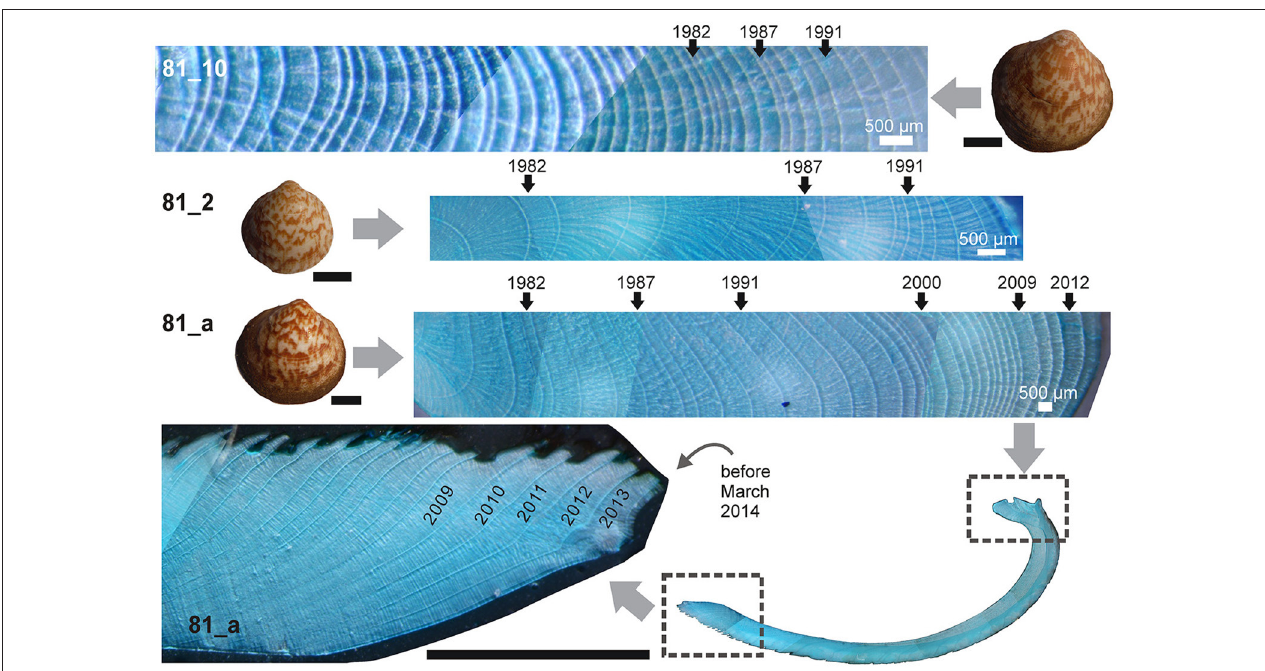
FIGURE 2 | Annual increments in the hinge portions of three Mutvei-stained samples (where 81_a is the specimen collected alive) augmented with a close-up micrograph of the stained section of the ventral margin and a panorama picture of the height-parallel section of the same specimen. Index years are indicated on their corresponding annual increments. Scale bars are 1cm for the accompanying photographs of G. vangentsumi